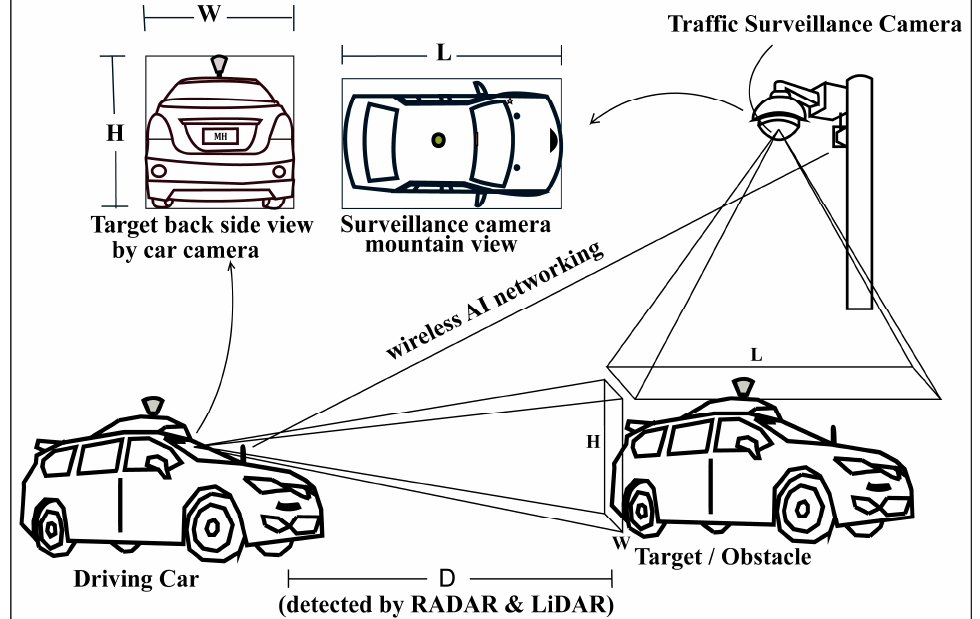
Figure 7. Proposed exact 4D detection and AI networking model for AV with traffic surveillance camera and car sensors.